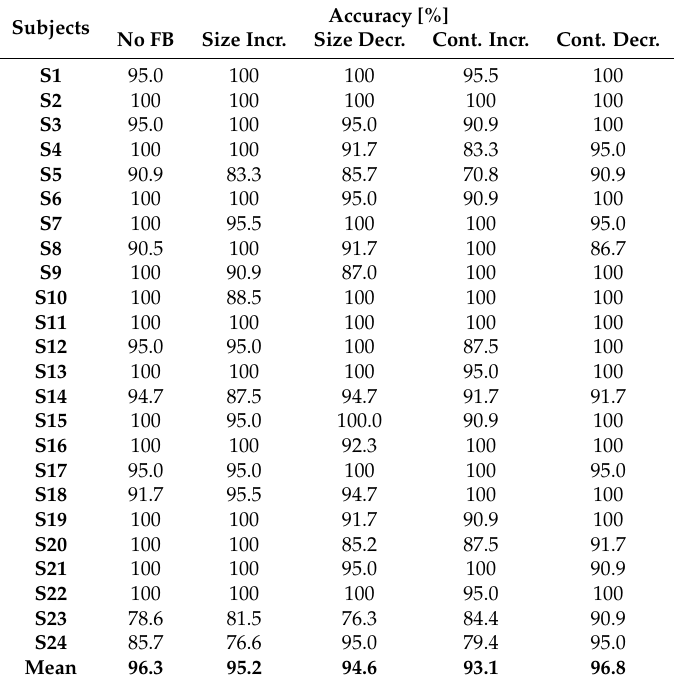
Table 1. The accuracy results with the interface. S1–S24 notes the subjects, and the different columns refer to different feedback methods (as compared to the no feedback condition, shown as ‘No FB’).